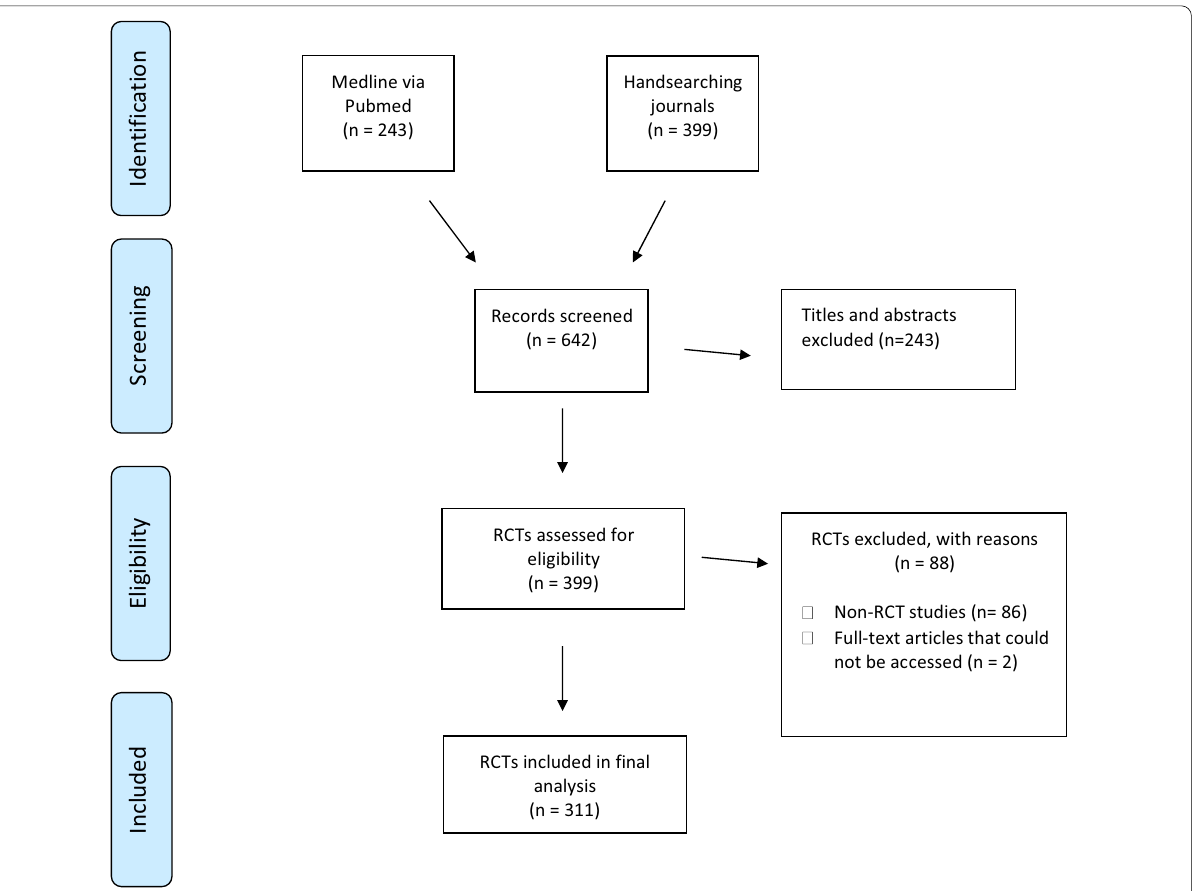
Fig. 1 RCT identification flow